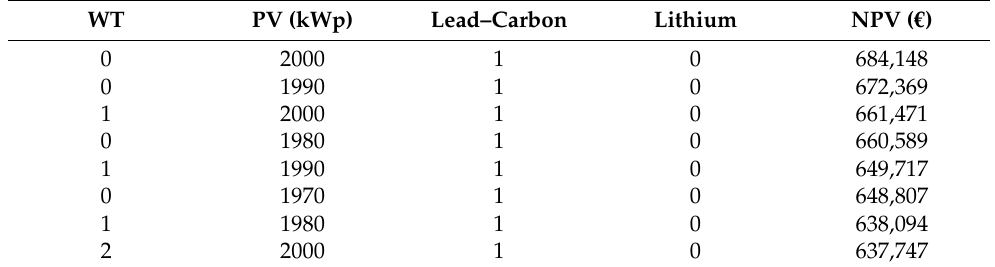
Table 3. Optimal results of the HMU campus microgrid considering the installation of a MV station.